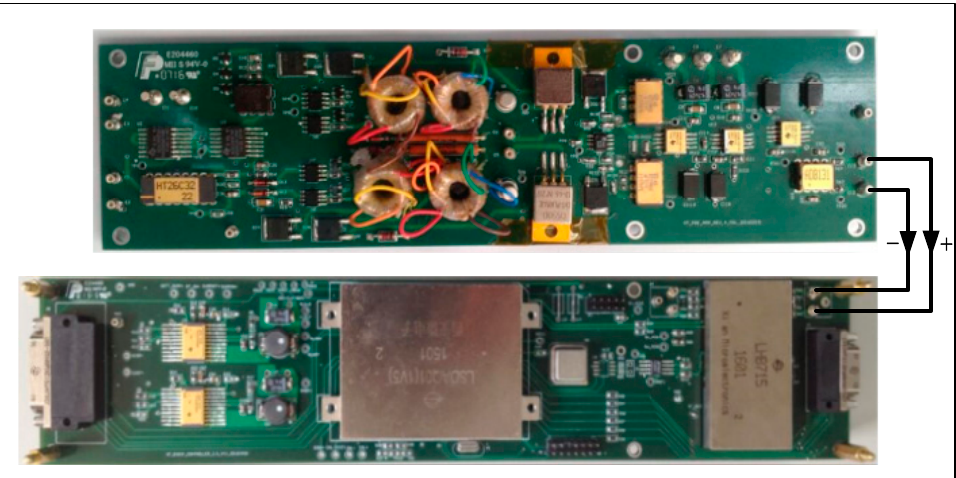
Figure 2. Photograph of the lock-in amplifier circuit, acquisition circuit, and processing circuit.